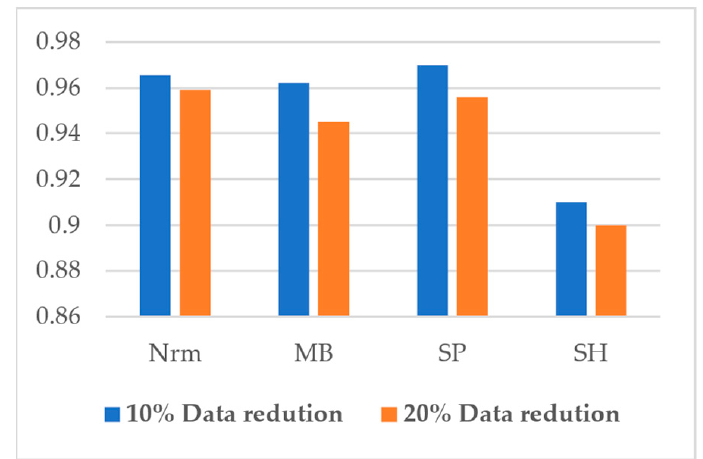
Figure 8. Impact of Data Reduction.